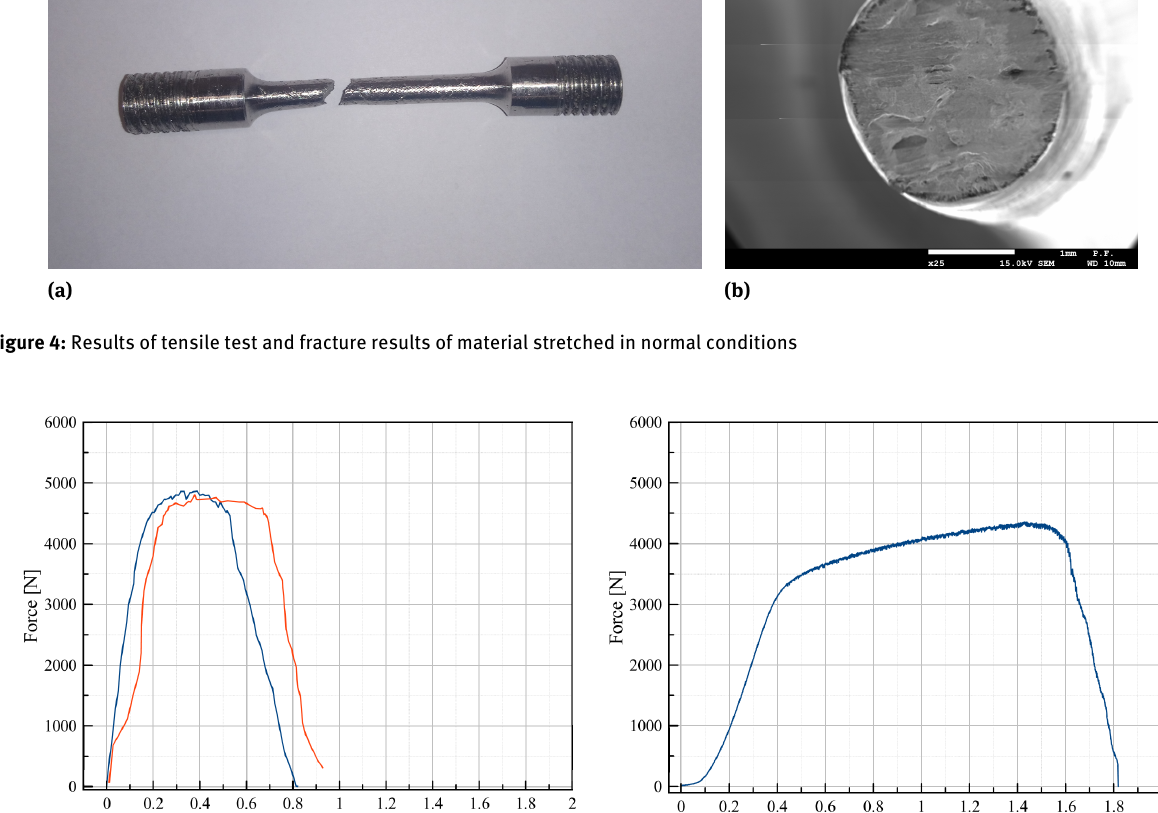
Failure of sample in normal conditions is typical for nickel based alloy, break was occurred along Luders